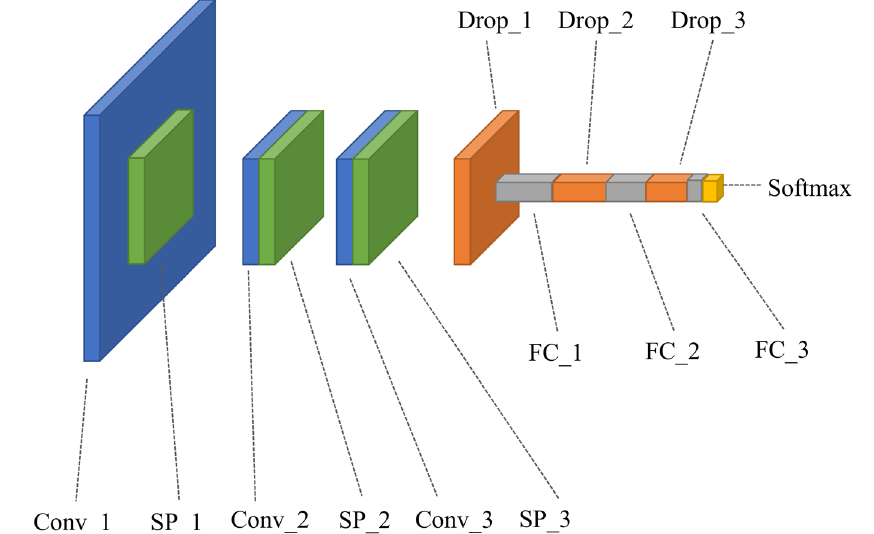
Figure 3. Structure of 6-layer stochastic pooling CNN.